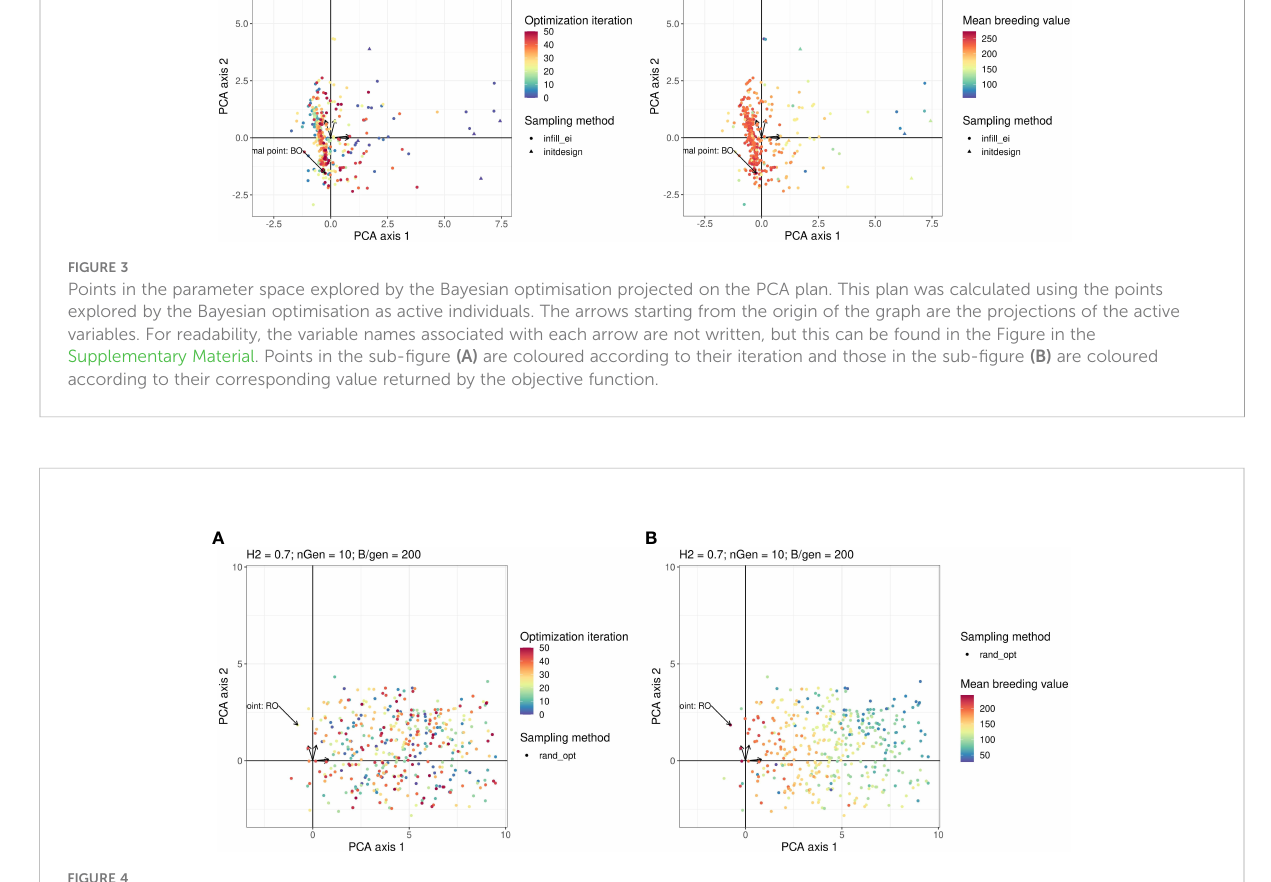
be found on the Figure in the Supplementary Material. Points in the sub- fi gure (A) are coloured according to their iteration and those in the sub- fi gure (B) are coloured according to their corresponding value returned by the objective